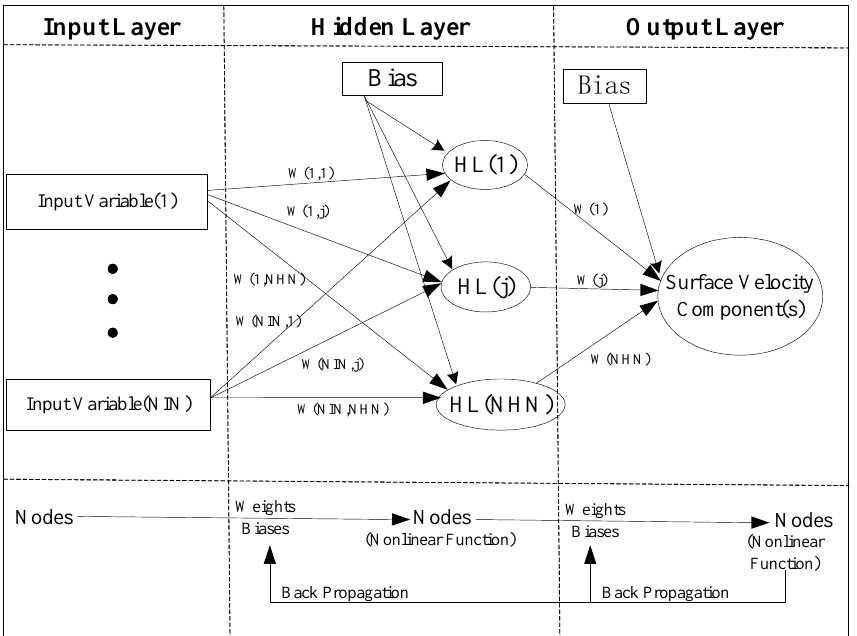
Figure 4. Schematic of a three-layer Artificial Neural Networks. w indicates weights, which varies at each connection; HL(j) indicates the 𝑗th node in the hidden layer; NIN indicates the total number of nodes in the input layer; and NHN indicates the total number of nodes in the hidden layer.